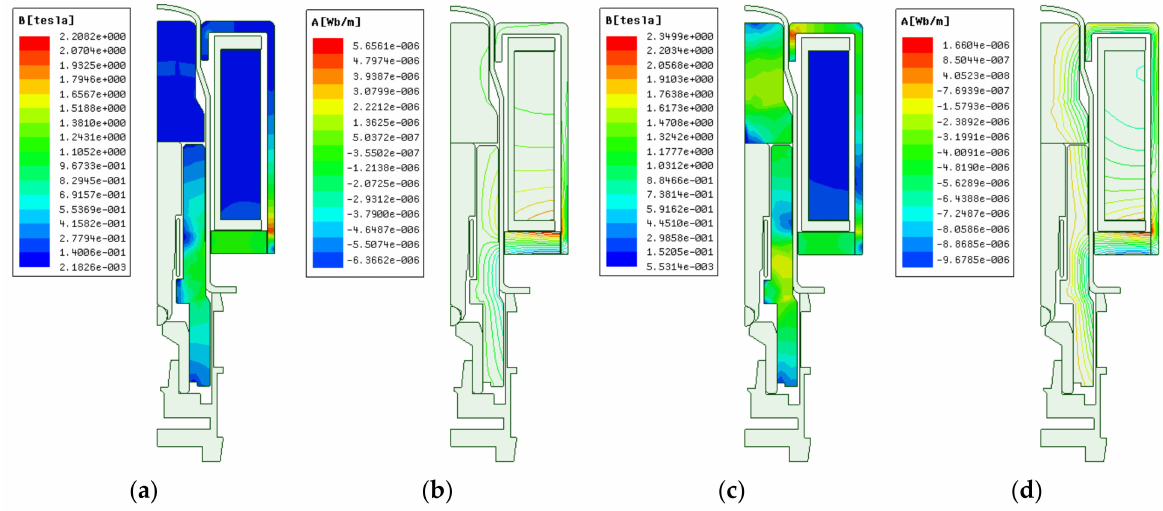
Figure 15. Permanent magnet TCV: ( a ) magnetic flux density at − 1.4 A; ( b ) magnetic field strength at − 1.4 A; ( c ) magnetic flux density at − 3.4 A; ( d ) magnetic field strength at − 3.4 A.